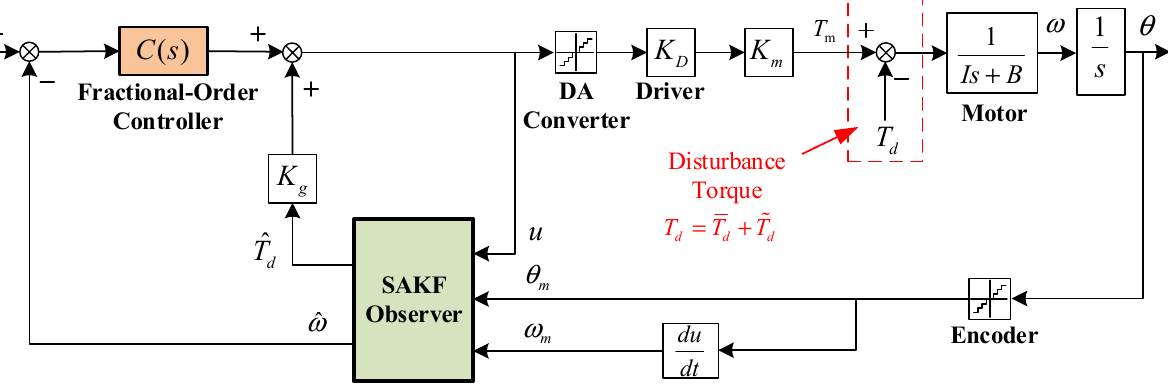
Figure 3. Block diagram of the proposed Compound control strategy.